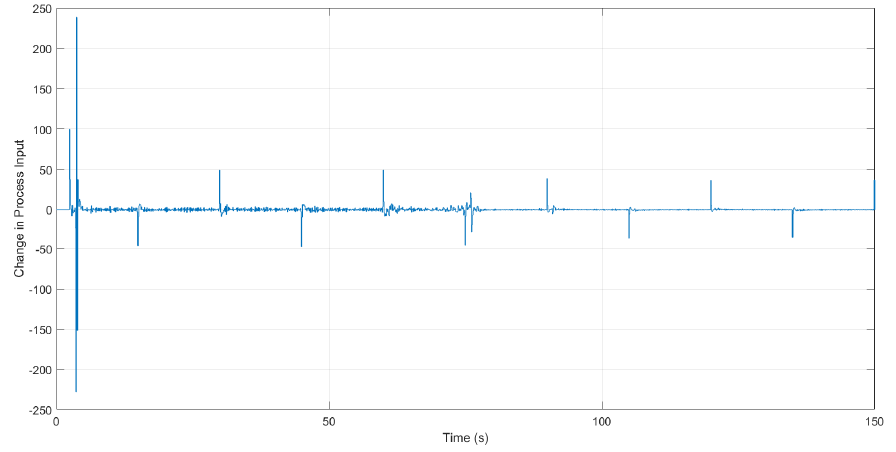
Figure 7. Rate-of-change of applied controls (process input) in the unconstrained Figure 7. Rate ‐ of ‐ change of applied controls (process input) in the unconstrained case.